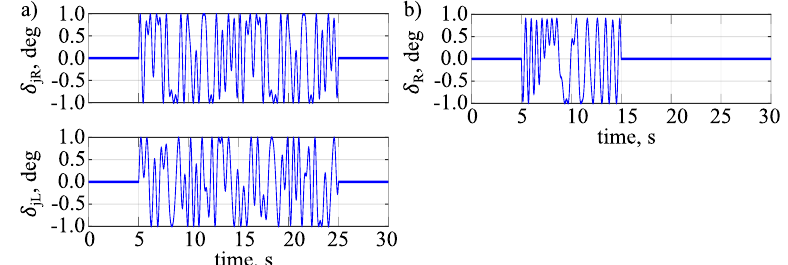
Figure 7. Multisine excitations for: ( a ) ailerons, elevator parts and flaps, ( b ) rudder. Table 2. Multisine inputs Right